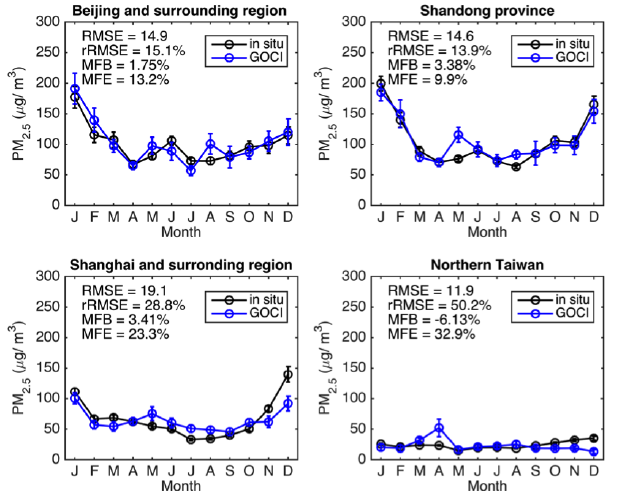
Figure 5. Monthly averages of daily PM 2 . 5 from in situ measure- ments and daily PM 2 . 5 estimated from GOCI AOD for 2013. Re- gions are defined in Fig. 3. Error bars represent standard errors. Statistics are root mean square error (RMSE), relative root mean square error (rRMSE), mean fractional bias (MFB) and mean frac- tional error (MFE).